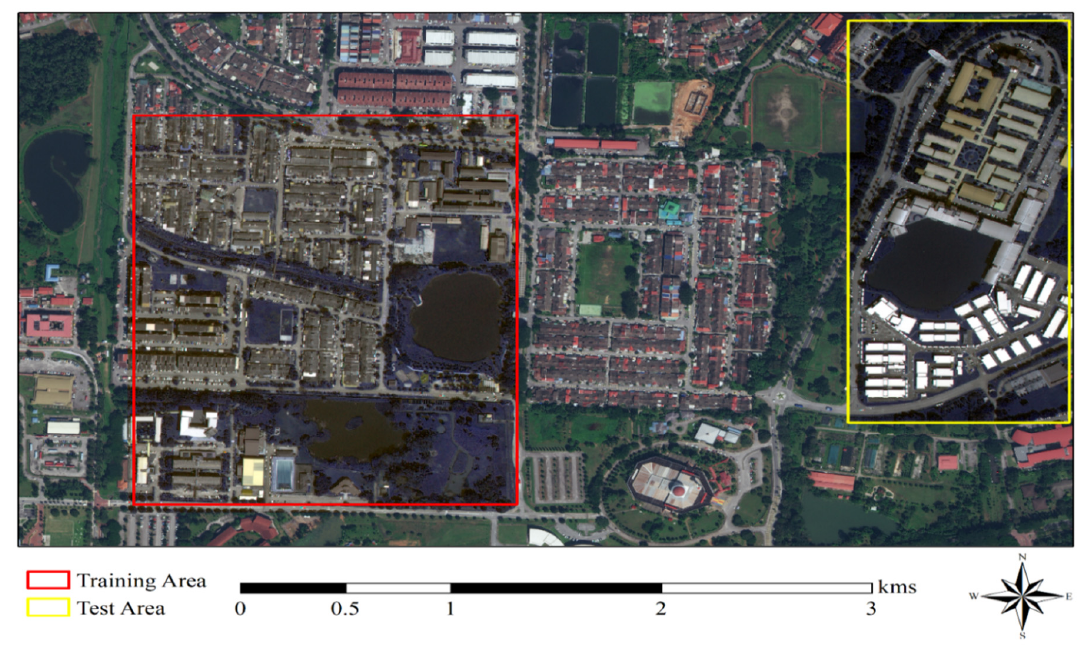
Figure 1. Location of the case study area and the training and test areas selected to develop and assess the proposed classification methods.